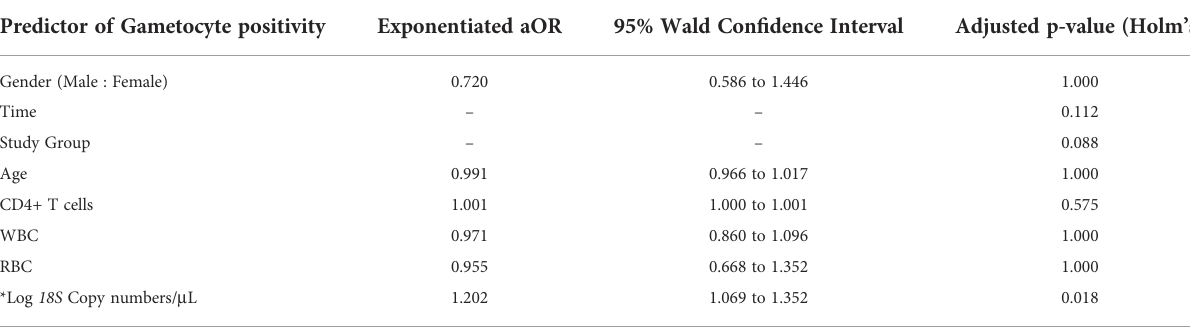
TABLE 1 GEE Omnibus Results.